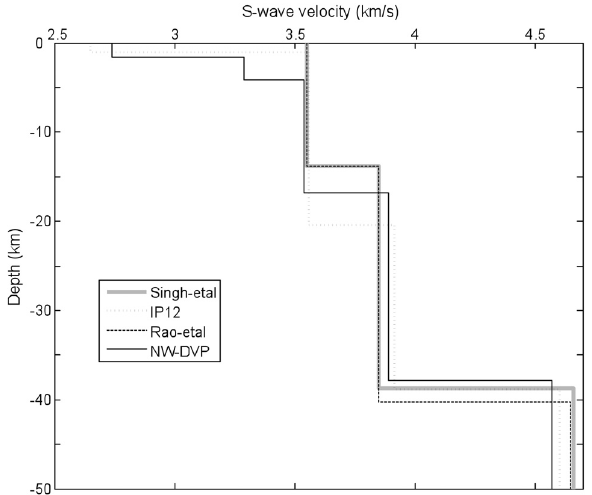
Figure 2. S -wave velocity structure of the Indian Peninsula in vari- ous studies: Singh-etal [Singh et al. 1999], IP12 [Bhattacharya 1992], Rao-etal [Rao et al. 2002], northwestern DVP [Prajapati et al. 2011]. Theoretical group velocity curves have been drawn in Figure 3 for these structures. IP12 is modified from IP11 [Bhattacharya 1981, 1992], whose top 1 km is replaced by a Deccan trap